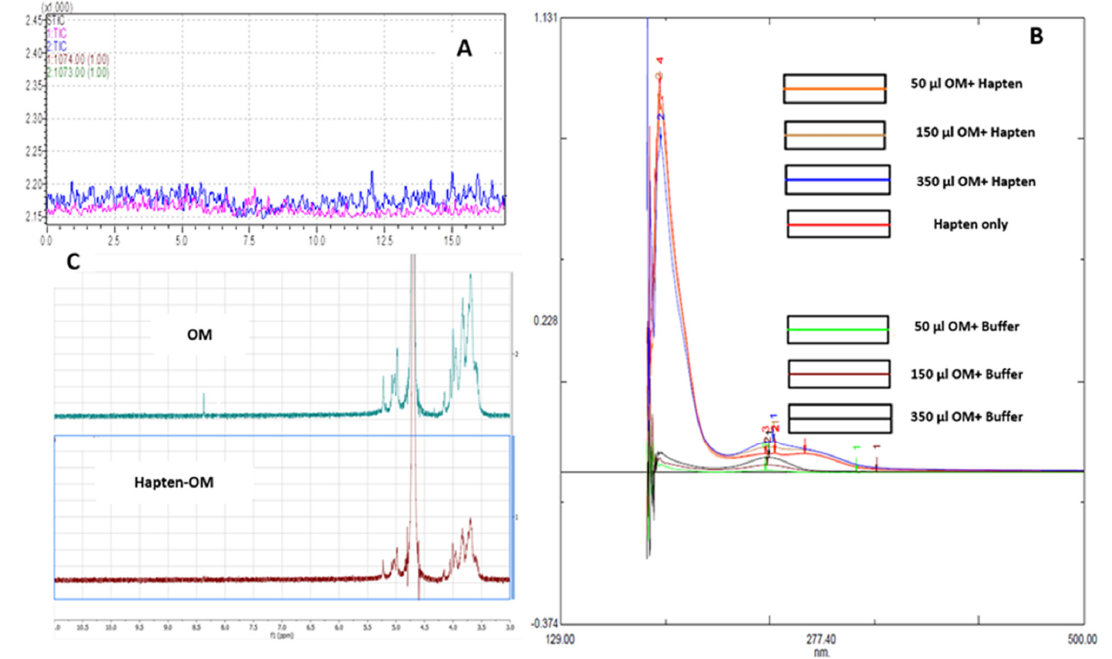
Figure 7. Confirmation of final vaccine by LC-MS, UV spectrophotometer and NMR. ( A ) Disappear- ance of METH hapten peak, ( B ) reaction titration between METH hapten and OM, ( C ) NMR spectrum of OM and hapten––OM conjugate.